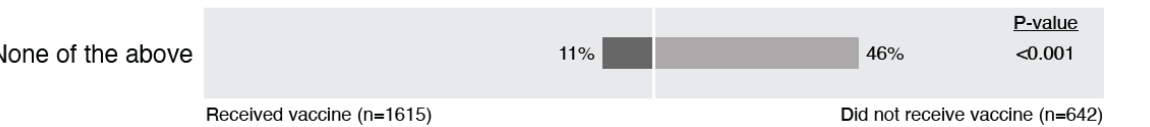
Figure 9. Differences in trust in no sources between vaccinated and unvaccinated EMS professionals.